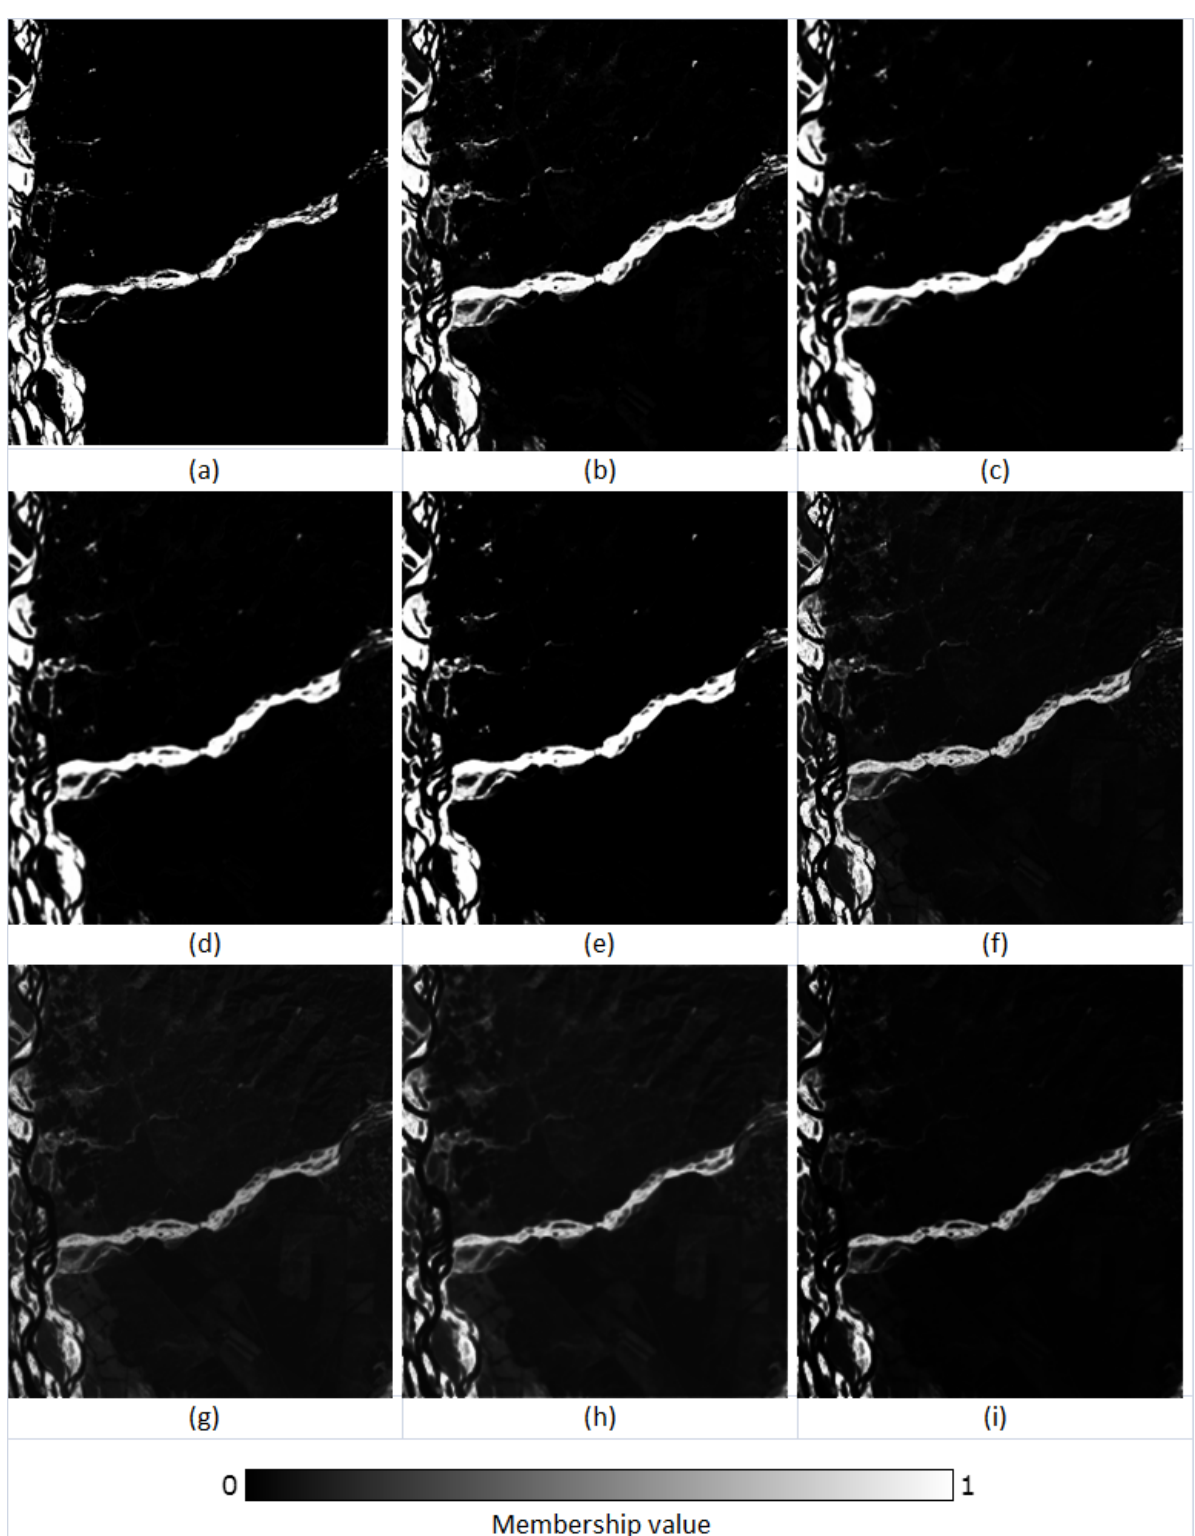
Figure 7. The membership fraction (0–1) for the class ‘Riverine Sand’ in ( a ) reference, ( b ) FCM output, ( c ) FCM-S output, ( d ) FLICM output, ( e ) ADFLICM output, ( f ) PCM output, ( g ) PCM-S output, ( h ) PLICM output, and ( i ) ADPLICM output.